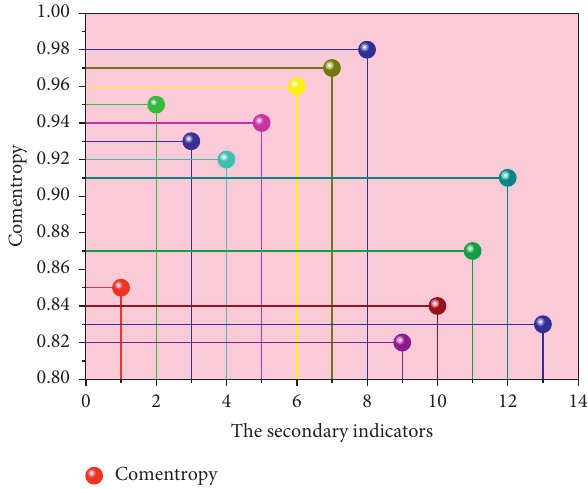
Figure 4: Statistical chart of information entropy of educational carrying capacity